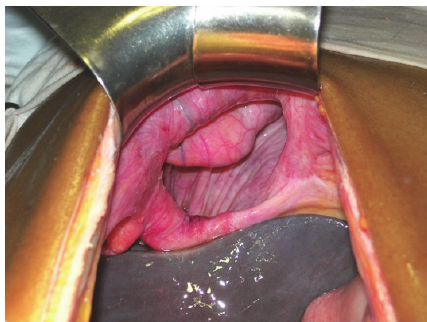
Figure 4: Intraoperative photo showing the right sided Morgagni’s hernial